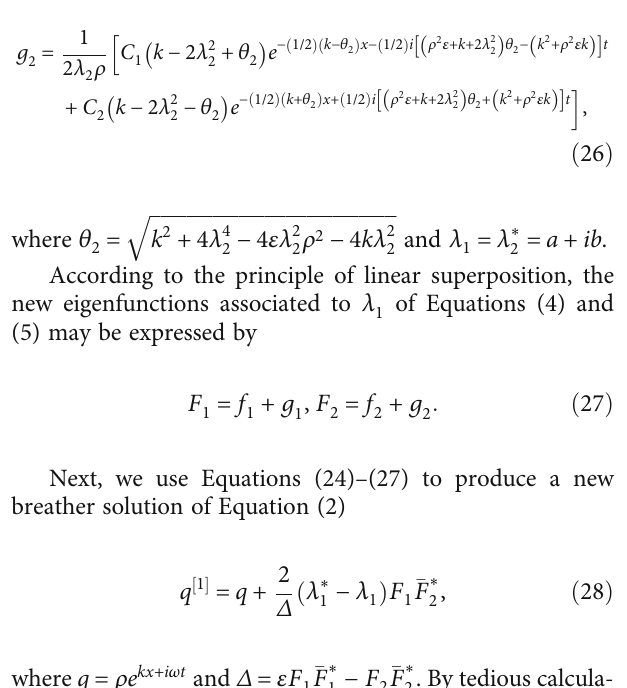
Figure 3: Evolution graph of the breather solution (32), (a) j q ½ 11 (cid:2) and t = 1 ,